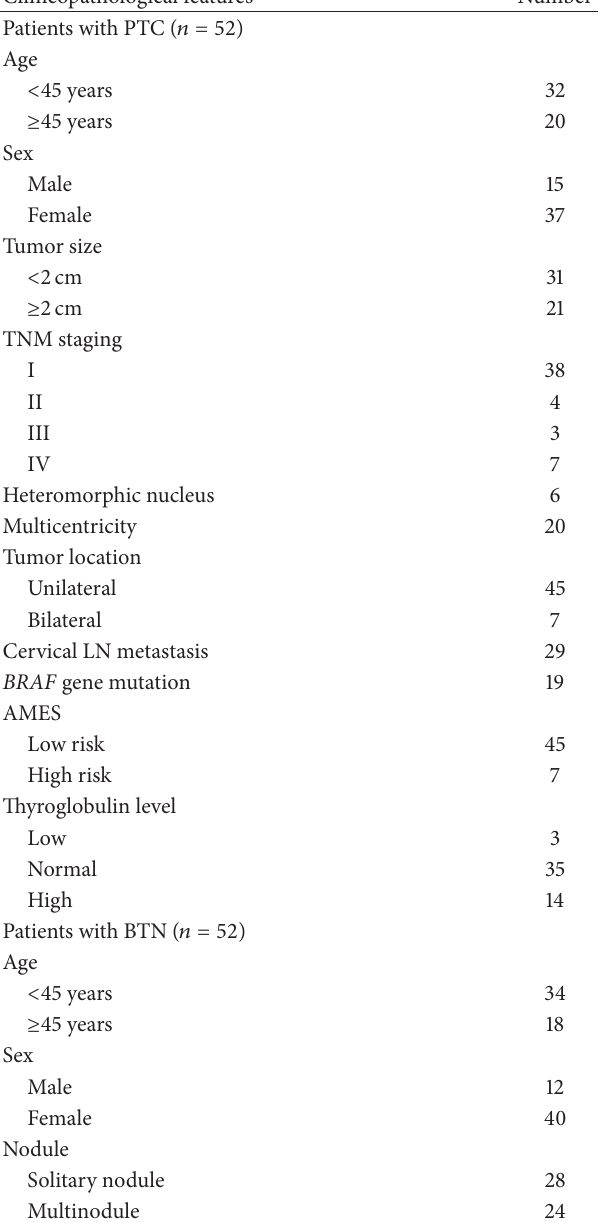
Table 1: The clinicopathological features of the study